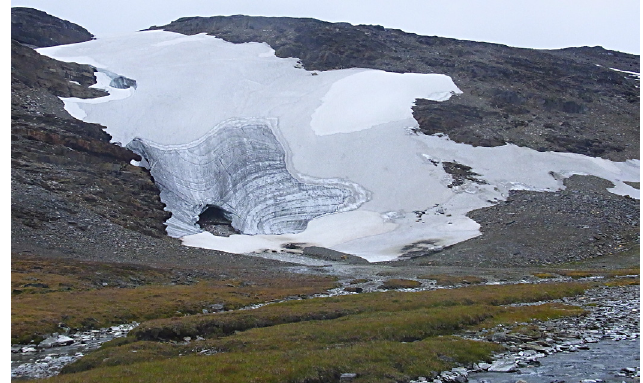
Figure 15: Kåppasglaciären (11) with its steep east-facing front. 2010-08-28.